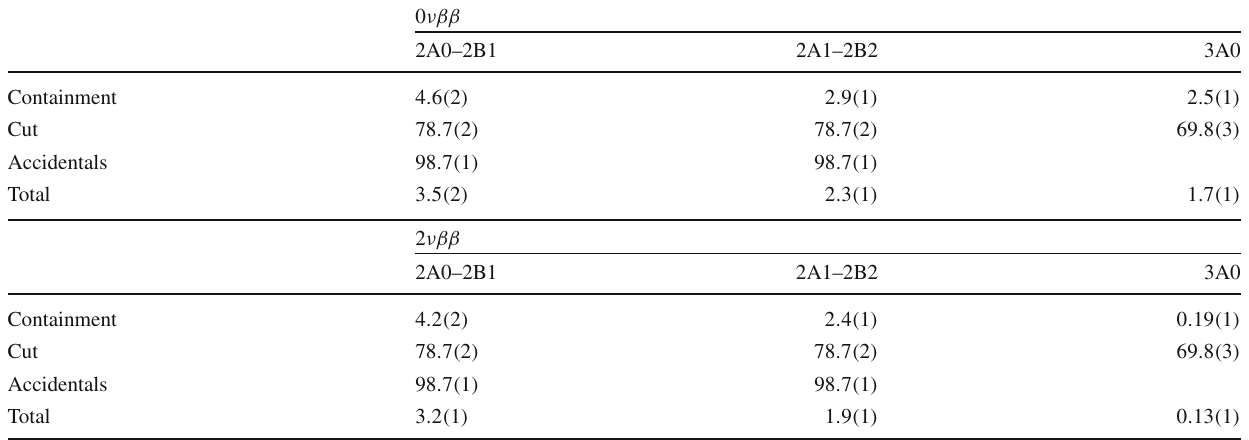
Table 2 We report the efficiency terms that appear in Eq. 7 separately for the 0 νββ (top) and 2 νββ (bottom) analyses. The containment term dominates the efficiency. We report the cut efficiency raised to power M according to the signature it refers to. We quote effective values com-